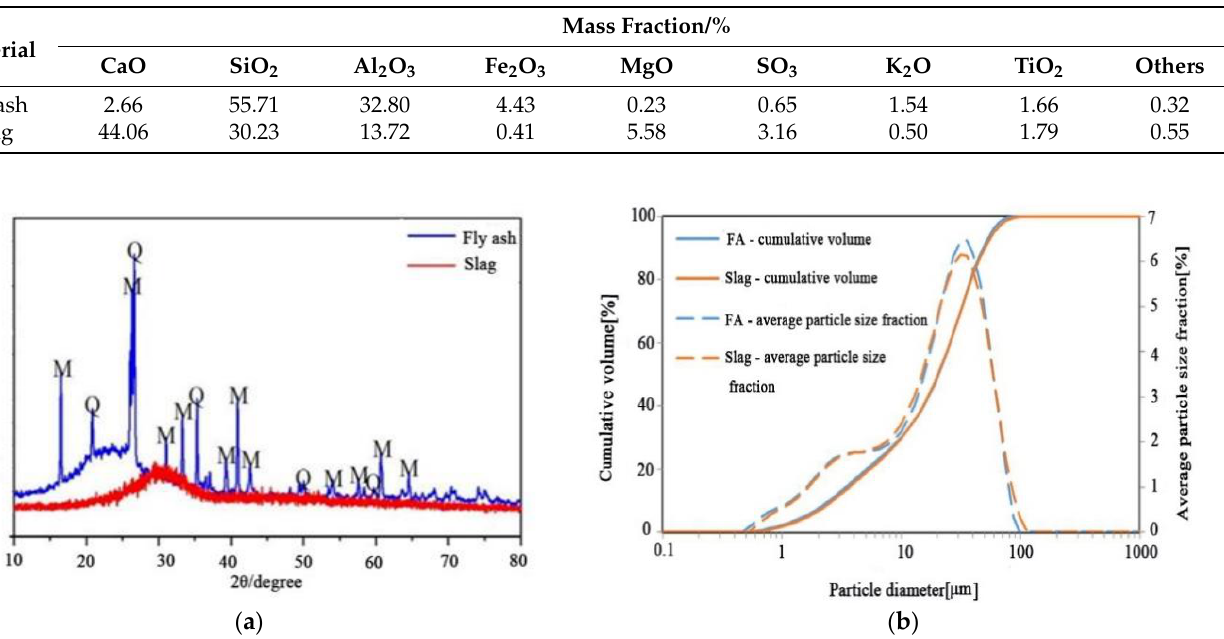
Figure 1. ( a ) XRD diagram of the materials (M-mullite; Q-quartz); ( b ) particle size distribution of the